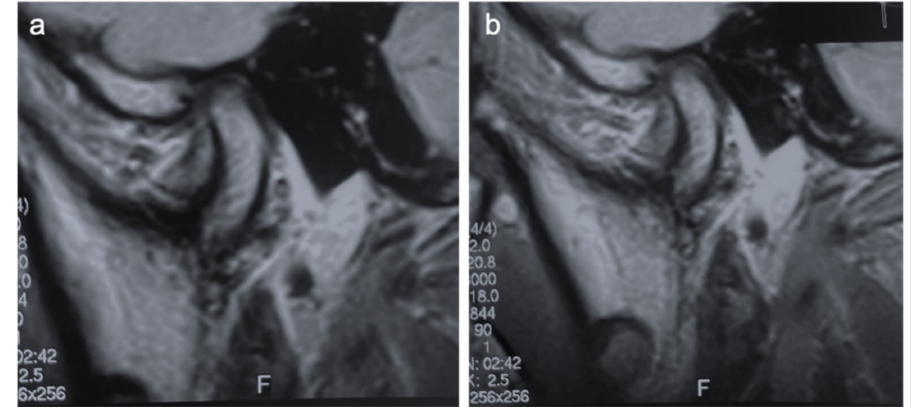
Figure 4. ( a , b ) MRI images at the right side: ( a ) closed mouth; ( b ) open mouth (age 10).